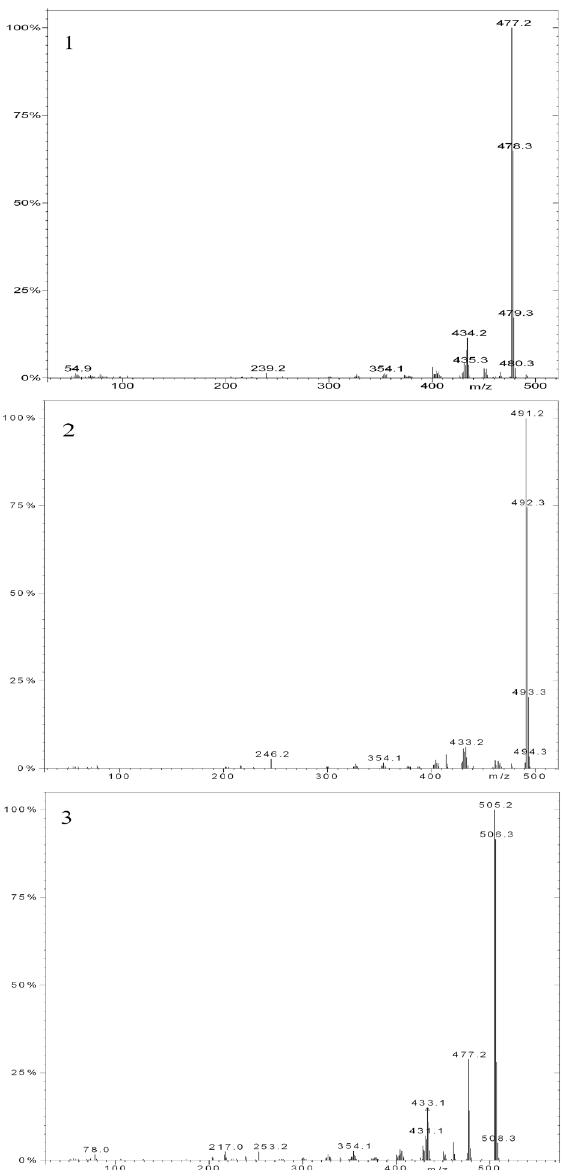
Figure 6: EI mass spectra of 1 - 3